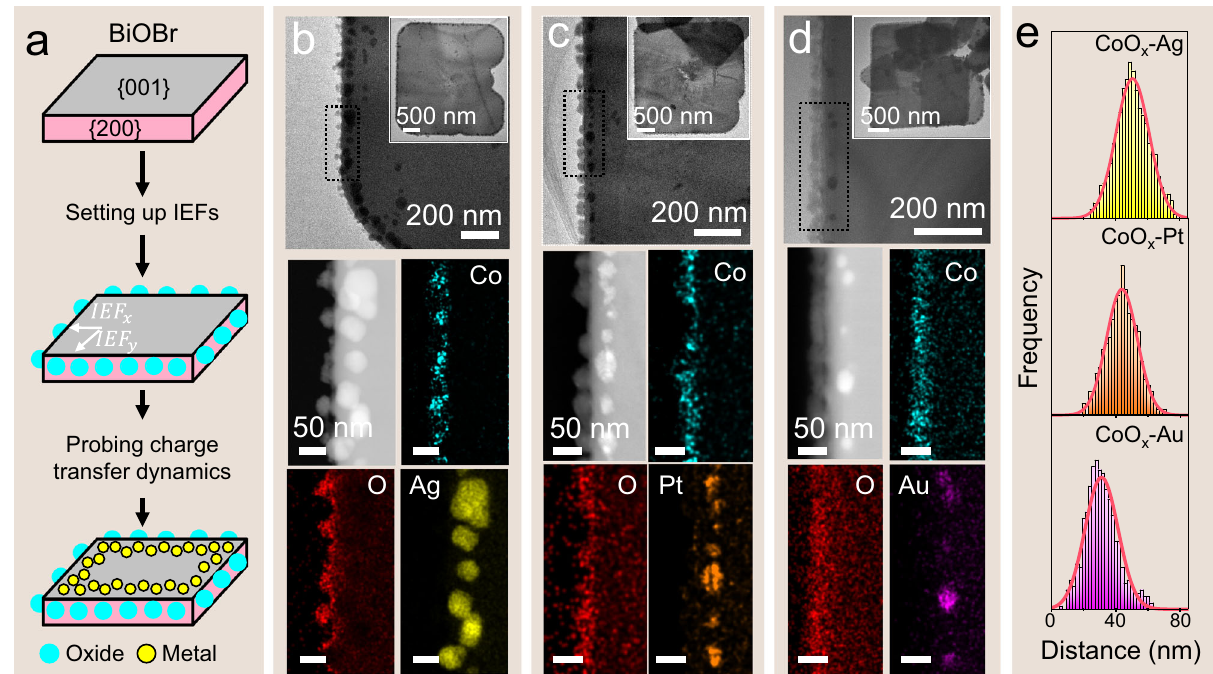
Fig. 3 The collective charge transfer pathway steered by IEFs. a Schematic illustration showing the construction of IEFs by photo-deposition of CoO x co- catalysts on the surface of BiOBr platelets, where a variety of metal species were employed as the probe to track the transfer pathway of electrons. TEM images and EDS maps show the photo-deposition of dual co-catalysts in the order of CoO x co-catalysts and Ag ( b ), Pt ( c ), or Au ( d ) nanoparticles. These samples are termed as CoO x -metal (Ag, Pt, or Au)/BiOBr. e Statistical histograms of the distances from the centers of metal nanoparticles to the BiOBr platelet edges, including the CoO x -Ag, CoO x -Pt, and CoO x -Au pairs. Source data are provided as a Source Data fi le. Table 1 A summary of the lateral drift distance, diffusion length, and average thickness for several metal nanoparticles/BiOBr photocatalysts groups.